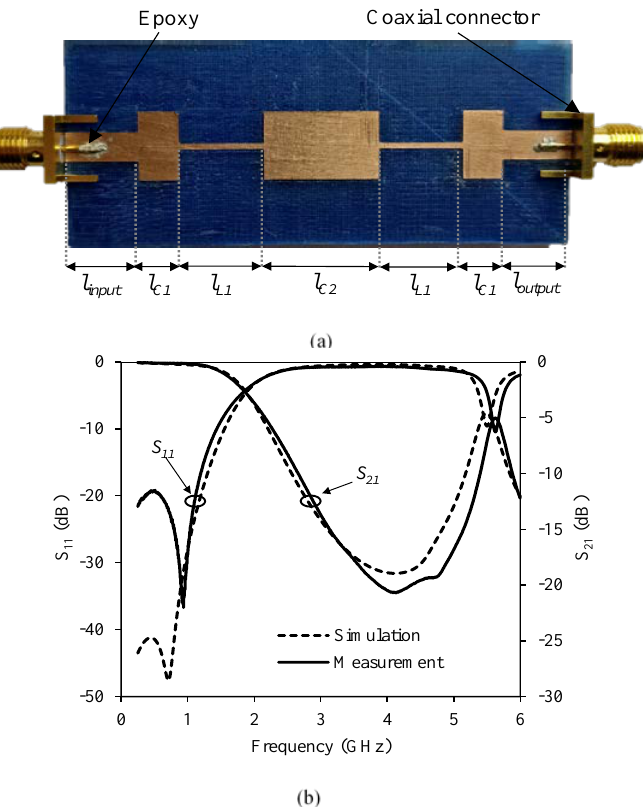
Figure 11. ( a ) Stepped impedance filter manufactured with 100% density. ( b ) Measured and simulated response of the stepped impedance filter with a 100% density substrate.